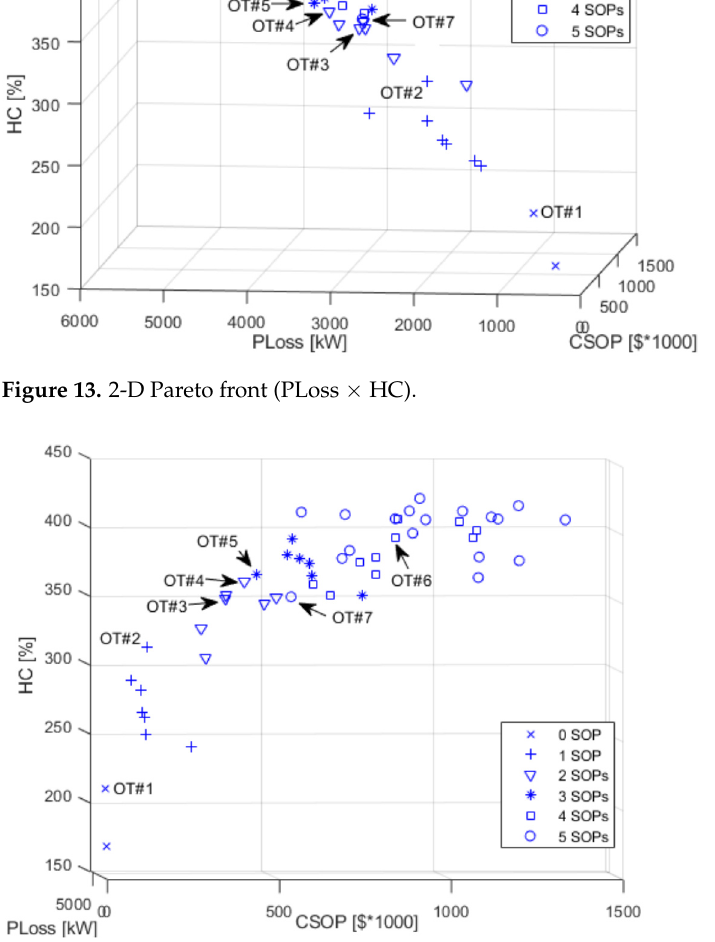
Table 8. Some solutions from the Pareto front.